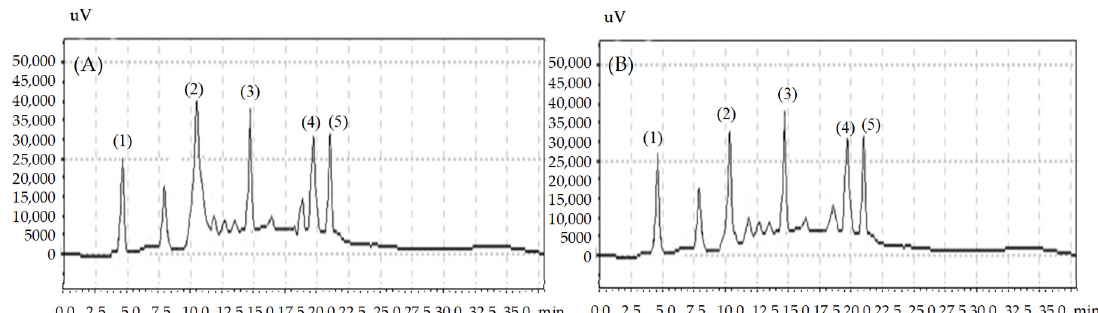
Figure 1. Chromatograms showing retention times and peak areas for phenolic acids in organic ( A ) and conventional ( B ) Gala apples, (1) gallic acid, (2) chlorogenic acid, (3) caffeic acid, (4) p -coumaric acid, and (5) ferulic acid.